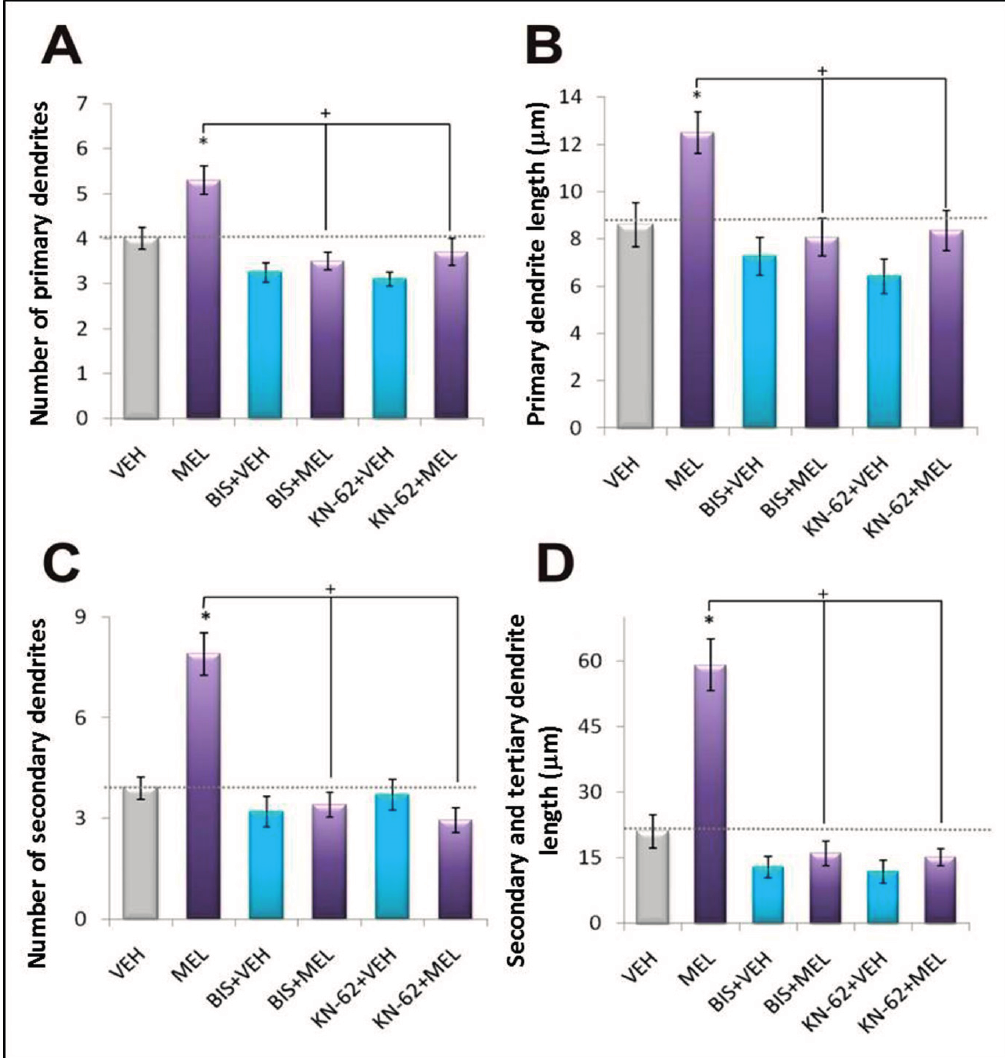
Figure 3. Morphometric analysis of dendritogenesis elicited by Melatonin: participation of Ca 2+ /CaM Kinase II and Protein Kinase C. The three stages of dendrite formation were evaluated by measuring the number and length of primary dendrites, as well as the number and length of secondary and tertiary dendrites. Hippocampal slices were incubated for 6 h with the following treatments: vehicle (VEH), 100 nM melatonin (MEL), pre- incubation of 15 min with 5 µM of the PKC inhibitor, bisindolylmaleimide (BIS) followed by the vehicle (BIS + VEH) or melatonin (BIS + MEL) for 6 h, or pre- incubation of 15 min with 10 µM of the CaMKII inhibitor, the KN-62 compound (KN-62) followed by the vehicle (KN-62 + VEH) or melatonin (KN-62 + MEL) for 6 h. After the incubation time, slices were cut into 50 µM sections and immunostained for the specific marker of dendrites MAP2. Slices were analyzed by the modified Sholl method. Results represent the mean ± SEM of one experiment of three done by quadruplicate. Asterisks show significant differences ( p < 0.05). ( A ) Number of primary dendrites; ( B ) Primary dendrite length (µm); ( C ) Number of secondary dendrites; ( D ) Secondary and tertiary dendrite length